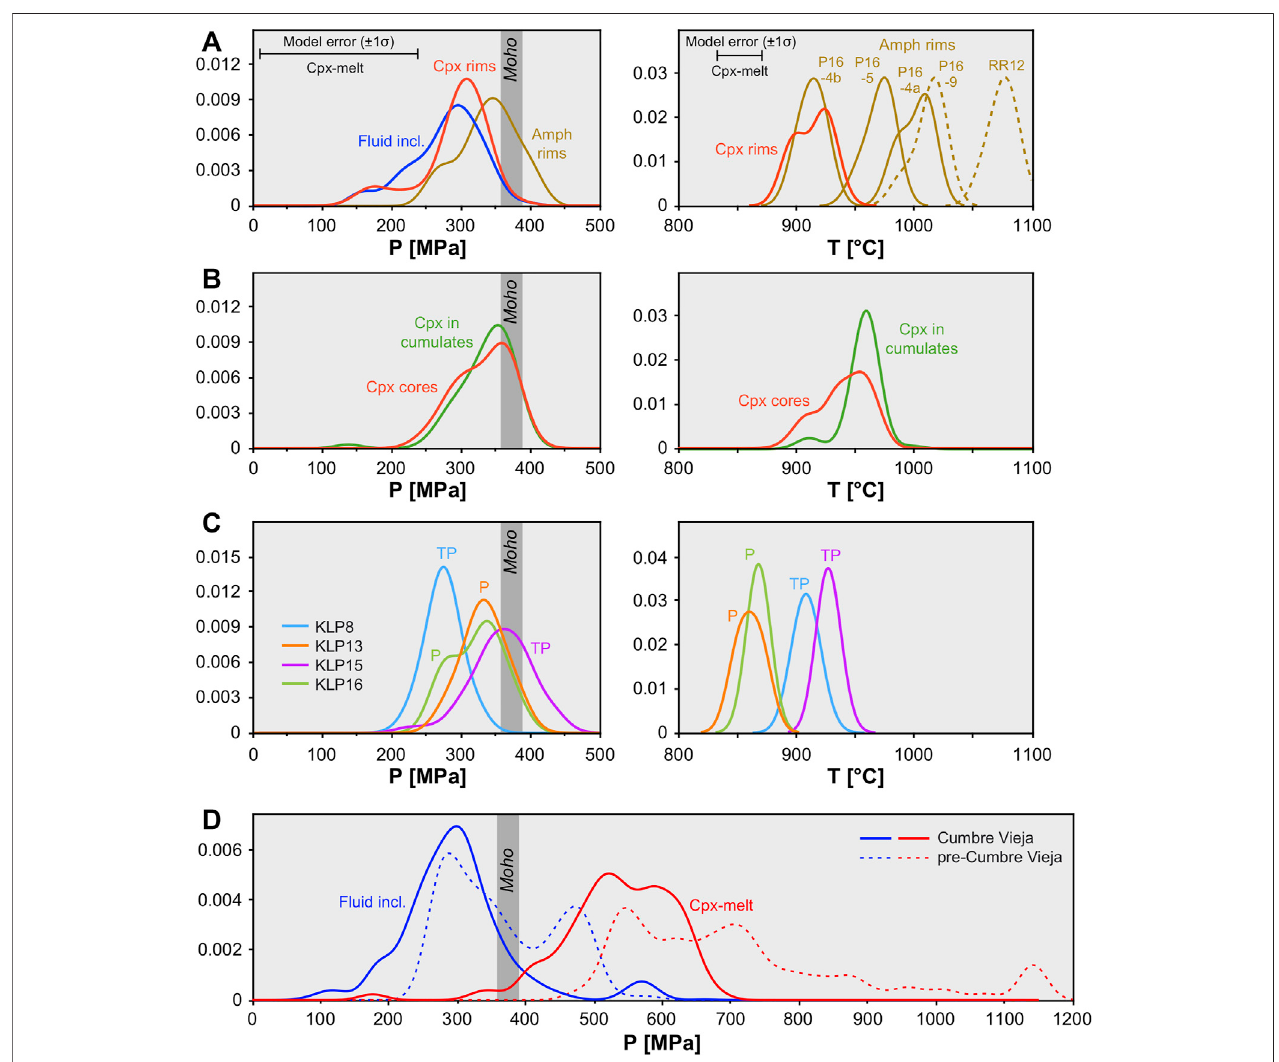
FIGURE8| Thermobarometricdatadisplayedaskerneldensityestimatesusingbandwithsof20 MPaforpressureand10 ° Cfortemperature.Asamplerepresents a single fl uid inclusion or mineral rim analysis in (A – C) , and the mean rim composition of a single crystal in (D) . Gray bars show the estimated pressure at Moho depth around La Palma (Ranero et al., 1995). (A) Left: Pressure estimates for tephriphonolite macrocryst rims derived from clinopyroxene-melt barometry (red line; model Palk2012 of Masotta et al., 2013), amphibole-melt barometry (brown line; Eq. 7a of Putirka, 2016), and fl uid inclusion barometry (blue line). Right: Temperature estimates for the same samples derived from clinopyroxene-melt thermometry (red line; model Talk2012 of Masotta et al., 2013), amphibole-melt thermometry (brown solid lines; Eqs 4a, 4b and 9 of Putirka, 2016),and amphibole-only thermometry (brown dashed lines; Ridol fi and Renzulli, 2012; Eq. 5 of Putirka, 2016).All rim analyses were paired with host groundmass analyses. (B) Pressure and temperature estimates for tephriphonolite macrocryst cores and cumulate xenolith crystals derived from clinopyroxene-meltthermobarometry,usingthemodelsPalk2012andTalk2012ofMasottaetal.(2013).Allclinopyroxeneanalyseswerepairedwithsuitablewhole-rock compositions from Cumbre Vieja ( see text for details). (C) Pressure and temperature estimates for other Cumbre Vieja tephriphonolites (TP) and phonolites (P) derived from clinopyroxene-melt thermobarometry (models Palk2012 and Talk2012 of Masotta et al., 2013). (D) Pressure estimates for basalts from Cumbre Vieja (solid lines) and frompre-CumbreViejaseries(dashedlines),obtainedbyclinopyroxene-melt barometryonphenocryst rims,and by fl uidinclusionbarometry(datafrom compilation in Klügel et al., 2015).